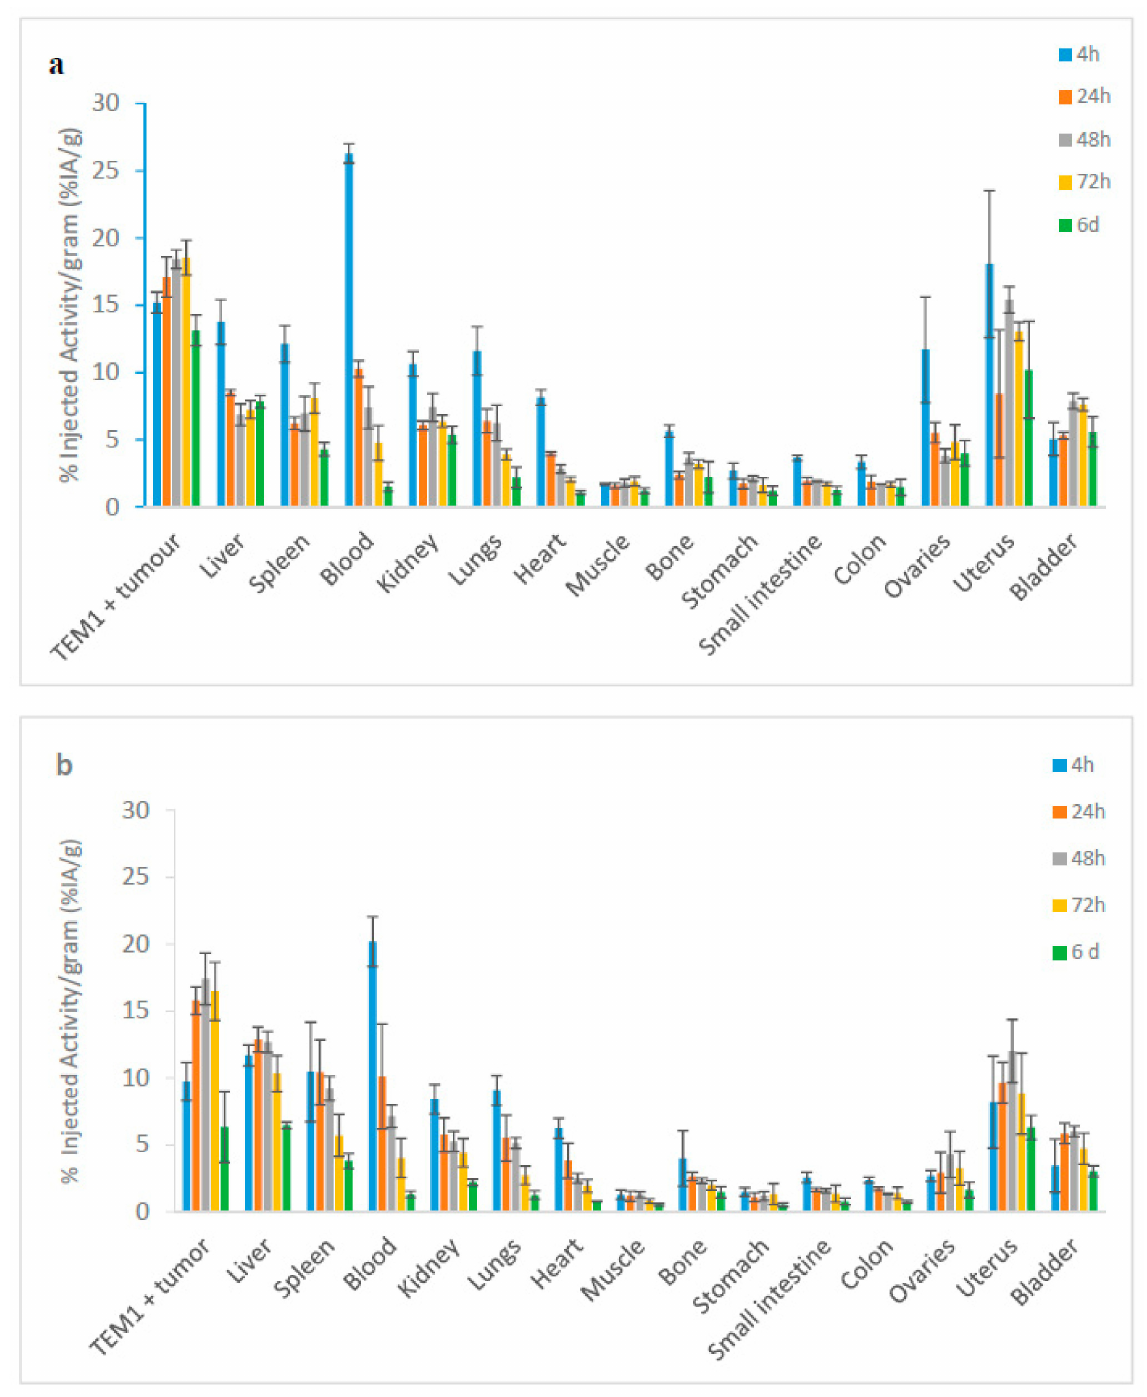
Figure 2. Biodistribution of [ 177 Lu]Lu-1C1m-Fc in Balb/c nu mice bearing TEM-1 positive tumor, ( a ) conjugated with 1 DOTA; ( b ) conjugated with 3 DOTA. Data are shown as mean ± SD, ( n =